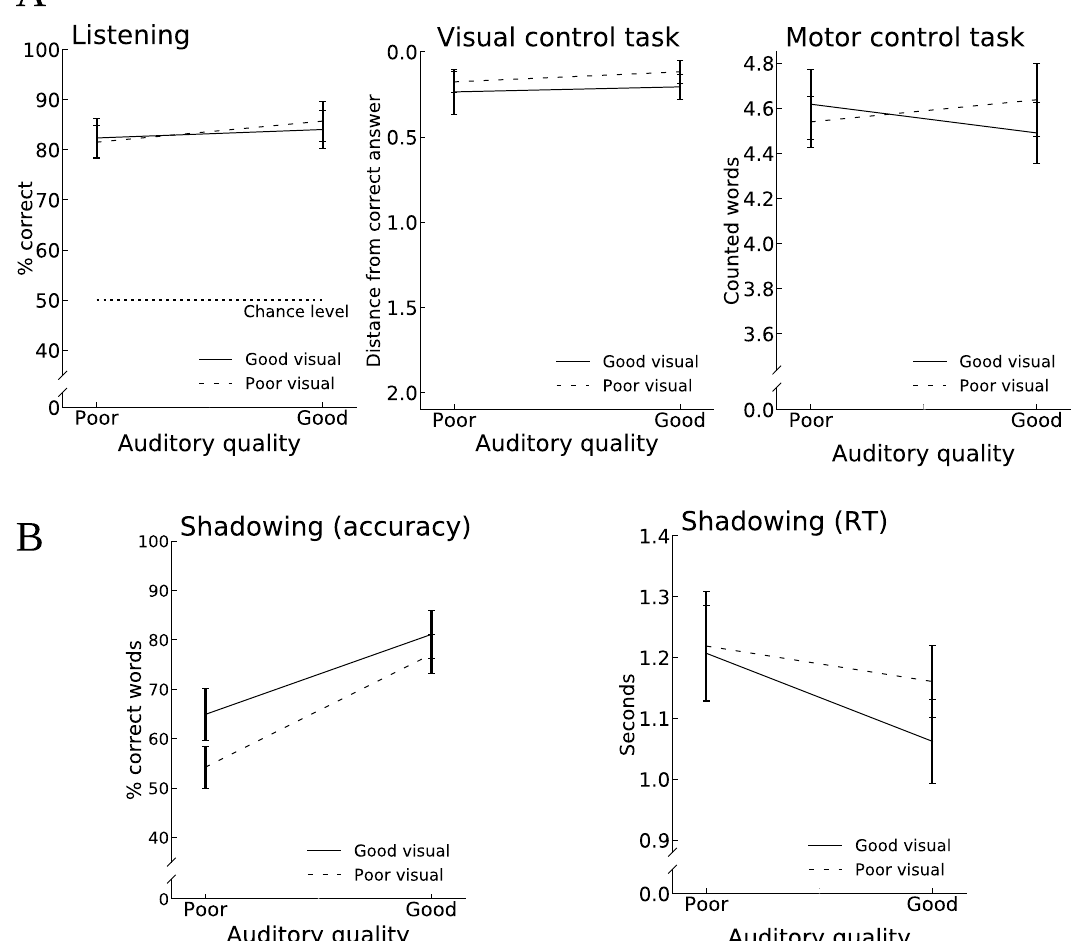
Figure 2. Behavioral performance in the four tasks and four audiovisual (AV) quality conditions (± SEM). ( A ) In the listening task, performance was above chance level in all conditions, but AV qualities had no significant effects on performance. In the visual control task, audiovisual qualities had no effect on task performance. In the motor control task, we only report the amount of overtly uttered numbers. ( B ) In the shadowing task Auditory quality had a significant effect on both accuracy and response time, and Visual quality had a significant main effect on accuracy. Auditory quality